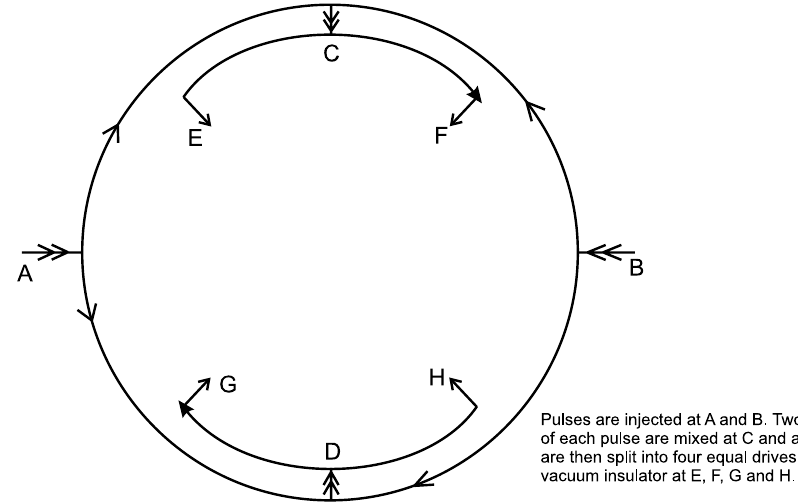
FIG. 24. Schematic of system of discrete transmission lines used to mix and symmetrize two pulse inputs in the cell of